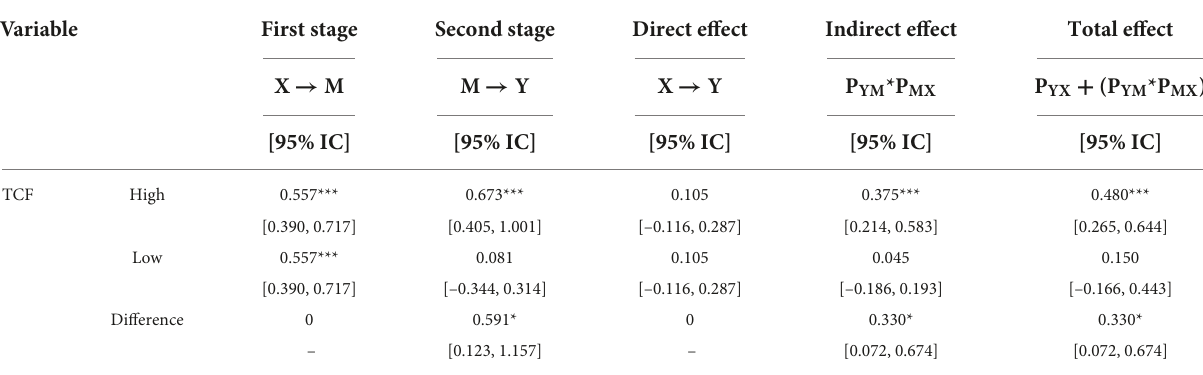
TABLE 4 Analysis results of moderated mediating effect